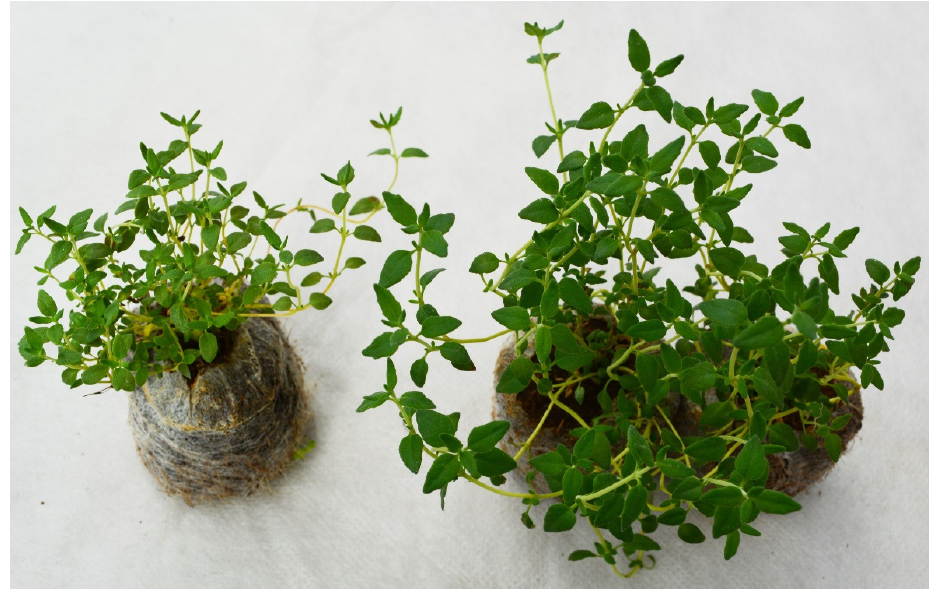
Figure 3. Plants of T. vulgaris in Jiffy pellets growing for two months ex vitro : diploid ( left ) and two tetraploid ( right ) plants from subclone TR15-22.